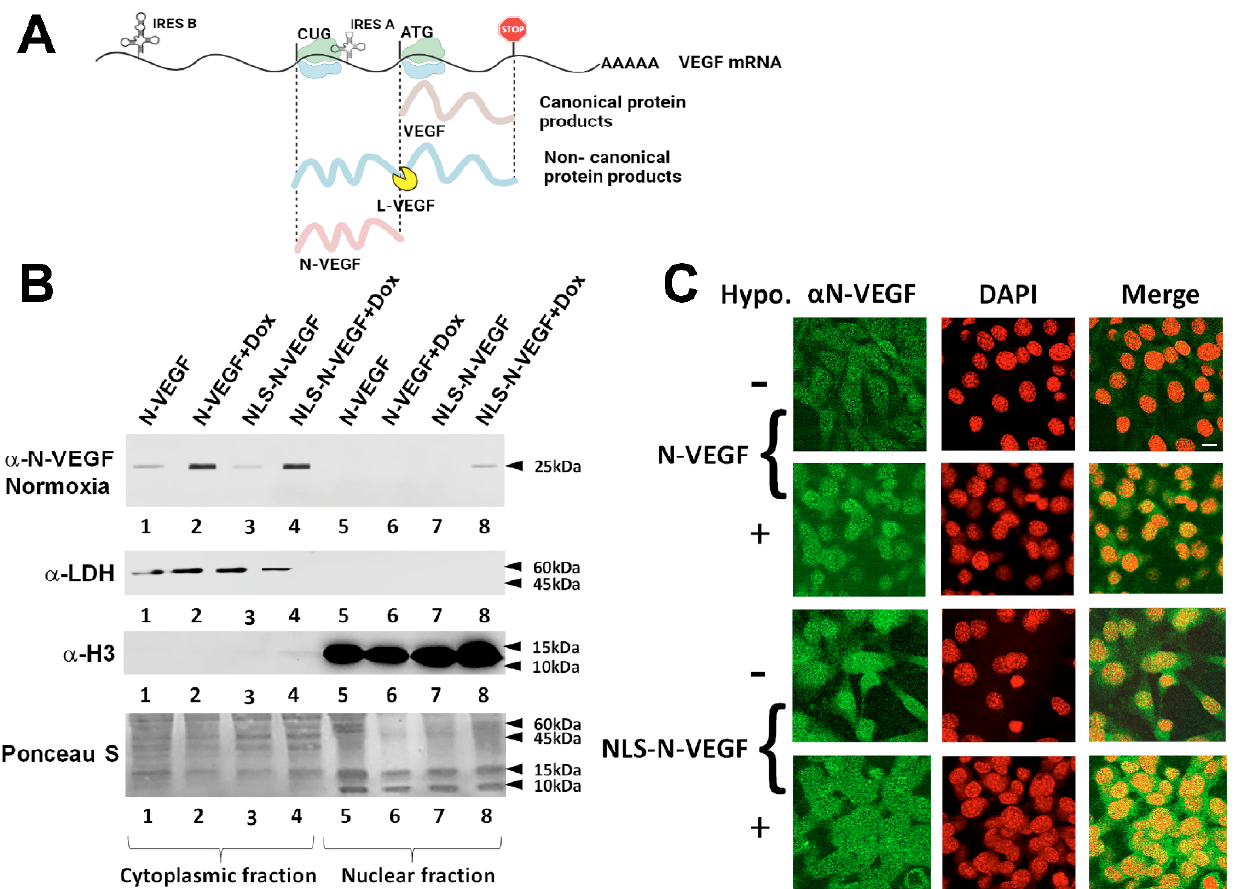
Figure 1. Hypoxia-independent nuclear mobilization of N-VEGF using the Cas9-NLS system. ( A ) Schematic illustration of the VEGF mRNA transcript, IRES domains, and the translated products. Two translational products are generated. The non-canonical L-VEGF translation start site is CUG , and the canonical start site of VEGF is ATG . The locations of IRES A and B promoting translation under hypoxic stress are indicated. VEGF and L-VEGF proteins are illustrated as well as the proteolytic cleavage site of L-VEGF resulting in N-VEGF. ( B ) NIH3T3 cells were transduced with either N-VEGF or NLS-N-VEGF expression constructs with or without the inducer of the Tet -on promoter (Dox). Nuclear as well as cytoplasmic fractions were obtained from these cells. Western blot with anti N-VEGF antibodies was performed on these extracts. Subsequent western blots on the same membrane were done using antibodies against LDH and histone H3 to show the purity of cytoplasmic and nuclei fractions, respectively. Ponceau S staining was carried out to demonstrate equal protein loading for all cytoplasmic and nuclear fractions. ( C ) Immunofluorescence of N-VEGF and NLS-N-VEGF cells before and following hypoxia (green) and nuclear staining with DAPI (red) is demonstrated. Minus sign represents normoxia, while plus sign hypoxia, Scale bar-50 µm.